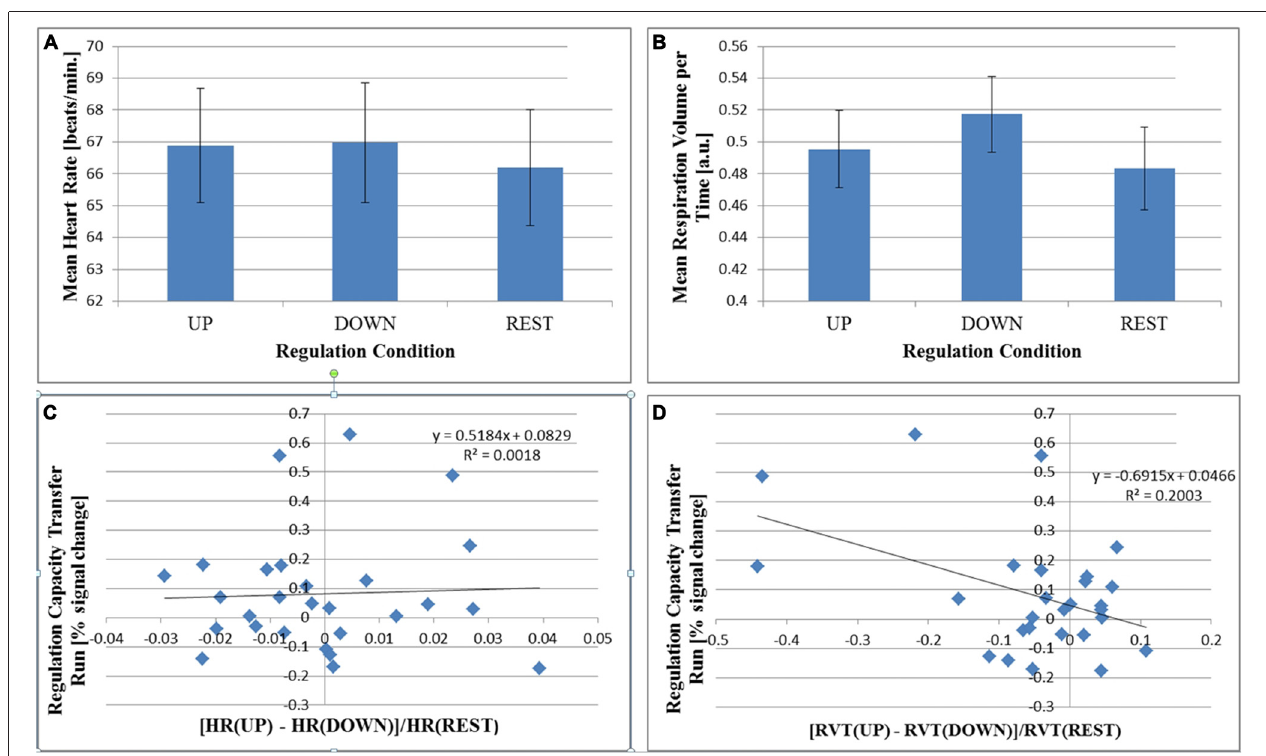
FIGURE 6 | Group mean values for heart rate (HR; A) and respiration volume per time (RVT; B) are shown for each regulation condition during the no-feedback transfer run ( N = 27; ± EOM). There is a significant within-subject effect of regulation condition for HR ( P = 0.004) driven by the difference between both “UP” and “DOWN” conditions with respect to “REST”. There is no significant difference between “UP” and “DOWN” conditions. For RVT, there is only a trend for a difference between conditions ( P = 0.051). In (C,D) , regulation capacity in the no-feedback transfer run is plotted as a function of the relative difference between “Up” and “DOWN” conditions in HR (C) and in RVT (D) . The Pearson correlation is significant for RVT ( P = 0.018, D ) but not for HR ( P = 0.853, C